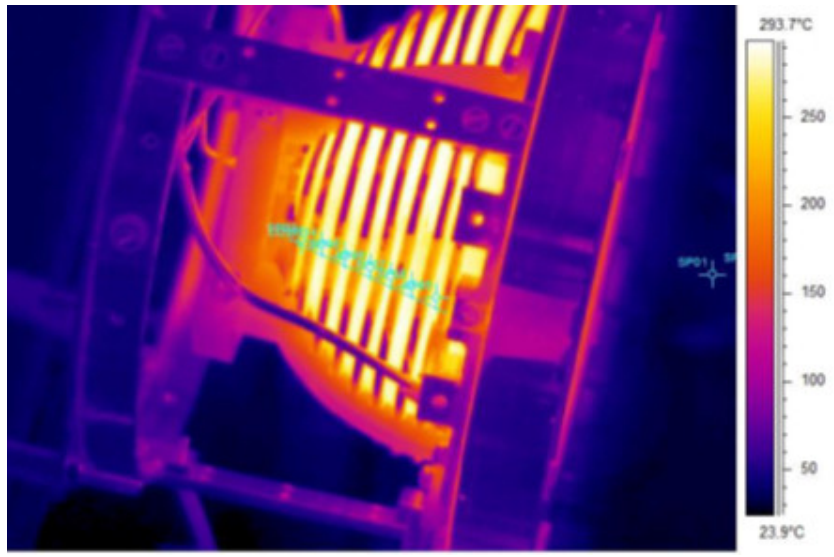
Figure 6. IS GDC thermogram.